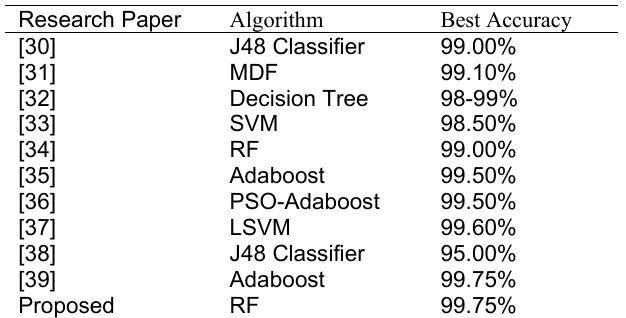
Table 1 3. Comparison with other research